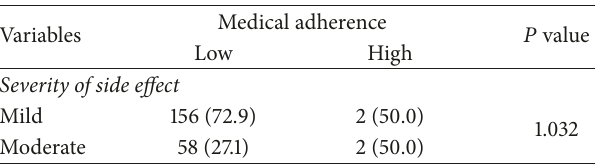
Table 10: Relationship between severity of side effect and adherence to psychotropic